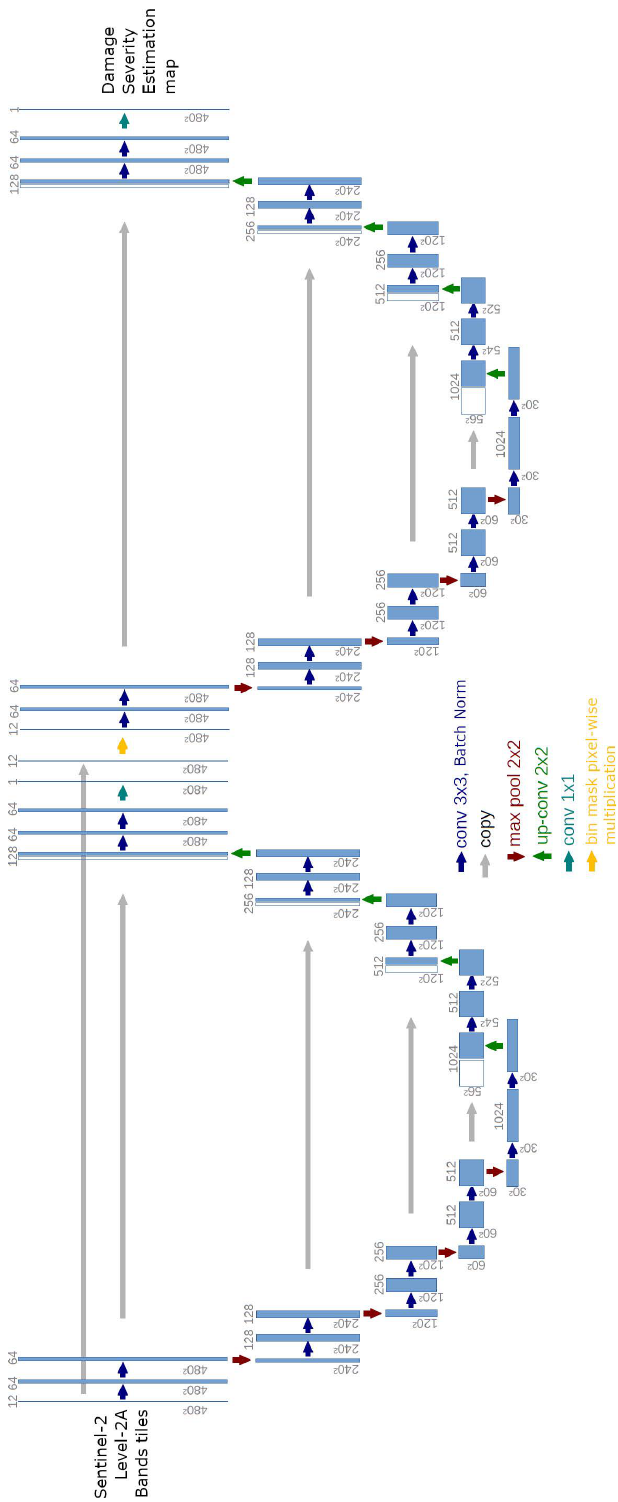
Figure A1. Double-Step U-Net